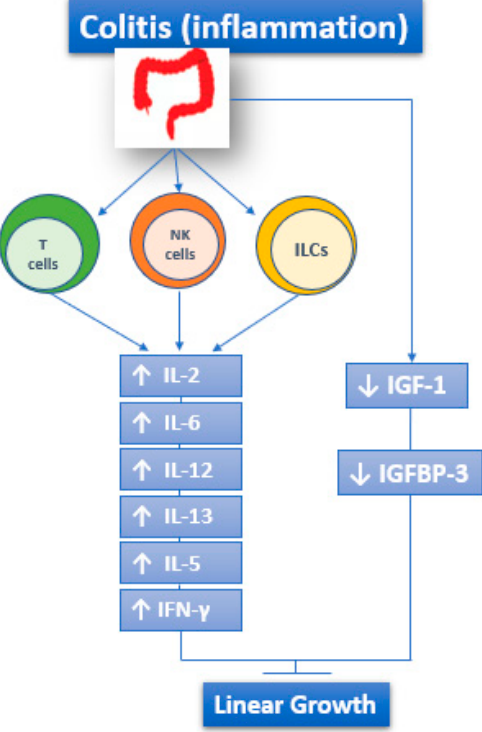
Figure 1. The role of immune response in IBD: both UC and CD are characterized by the increased and sometimes massive production of IL-2, IL-12, IL-6, IFN- γ , IL-5, and IL-13. ILCs: Innate Lymphoid cells.